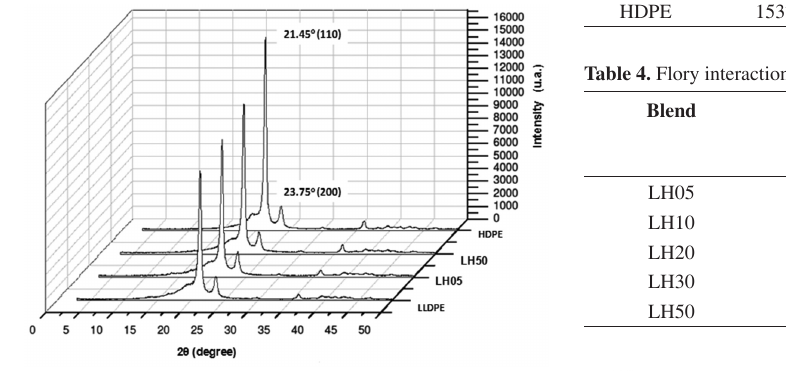
Figure 3. X-Ray spectra of the blends and the neat polymers.